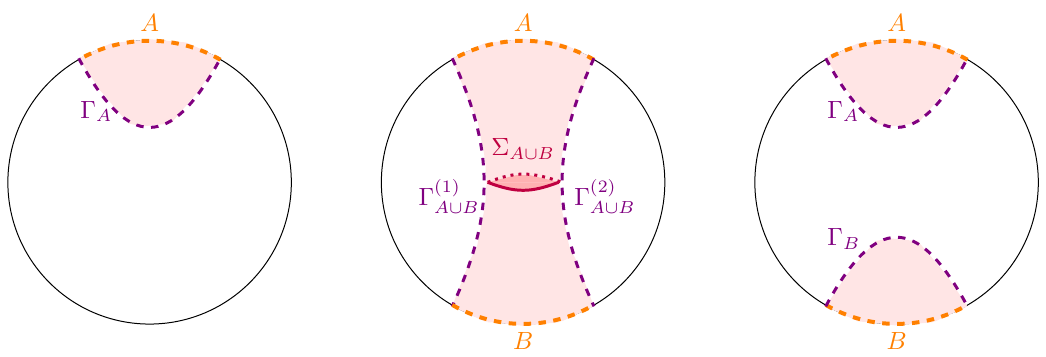
Figure 1 . Left : the shaded region is the entanglement wedge corresponding to the boundary sub- region A . Middle : the case where the entanglement wedge is connected, i.e., Γ A ∪ B = Γ (1) In this case EWCS is proportional to the area of Σ A ∪ B . Right : the case where the entanglement wedge is disconnected, i.e., Γ A ∪ B = Γ A ∪ Γ B and the corresponding EWCS